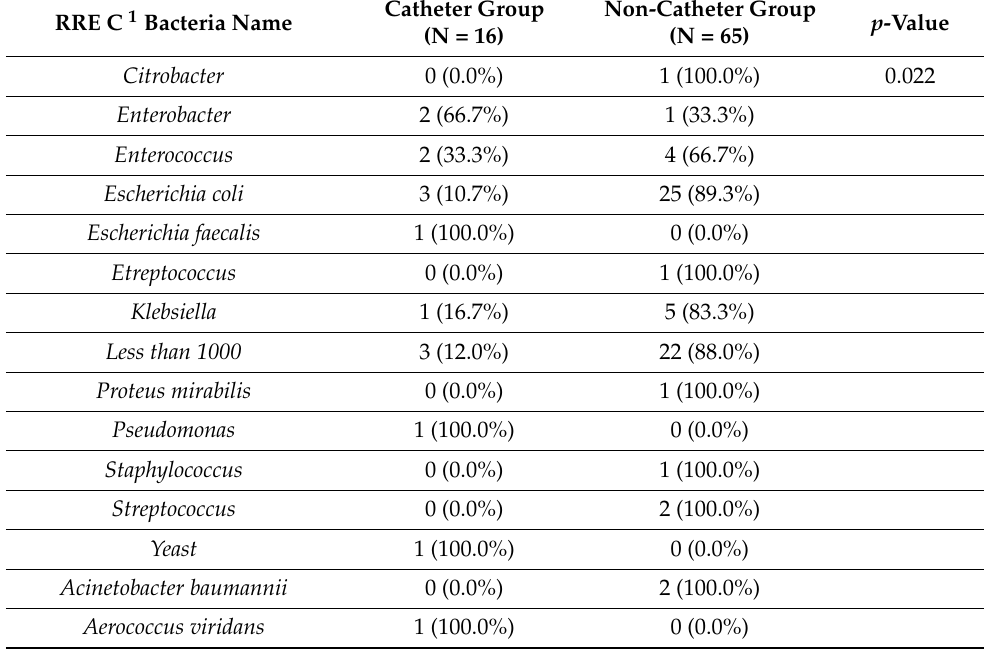
Table 3. The results of the urine cultures before